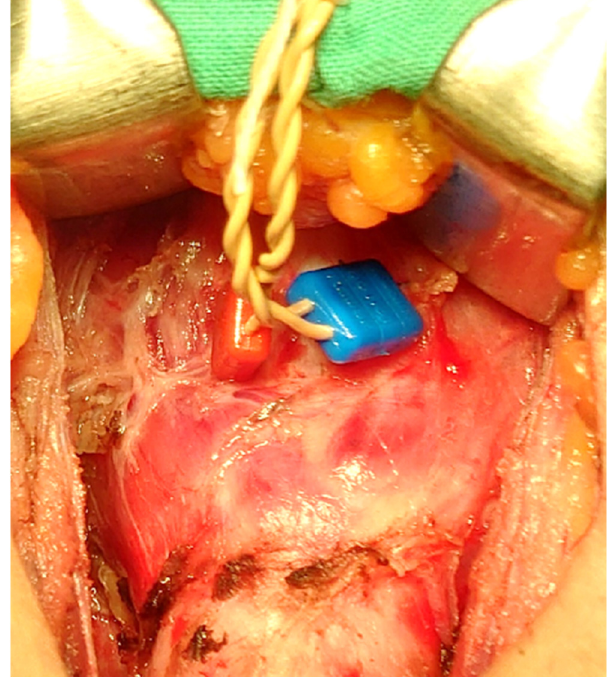
Figure 3. TC recording electrodes through the thyroid cartilage and perichondrium. Ideal but invasive technique when it is not possible to use the electrodes placed on ETT. The placement of the TC must be meticulous because the children’s larynx is small and soft. Abbreviations: TC: transcartilage recording electrode; ETT: endotracheal tube.